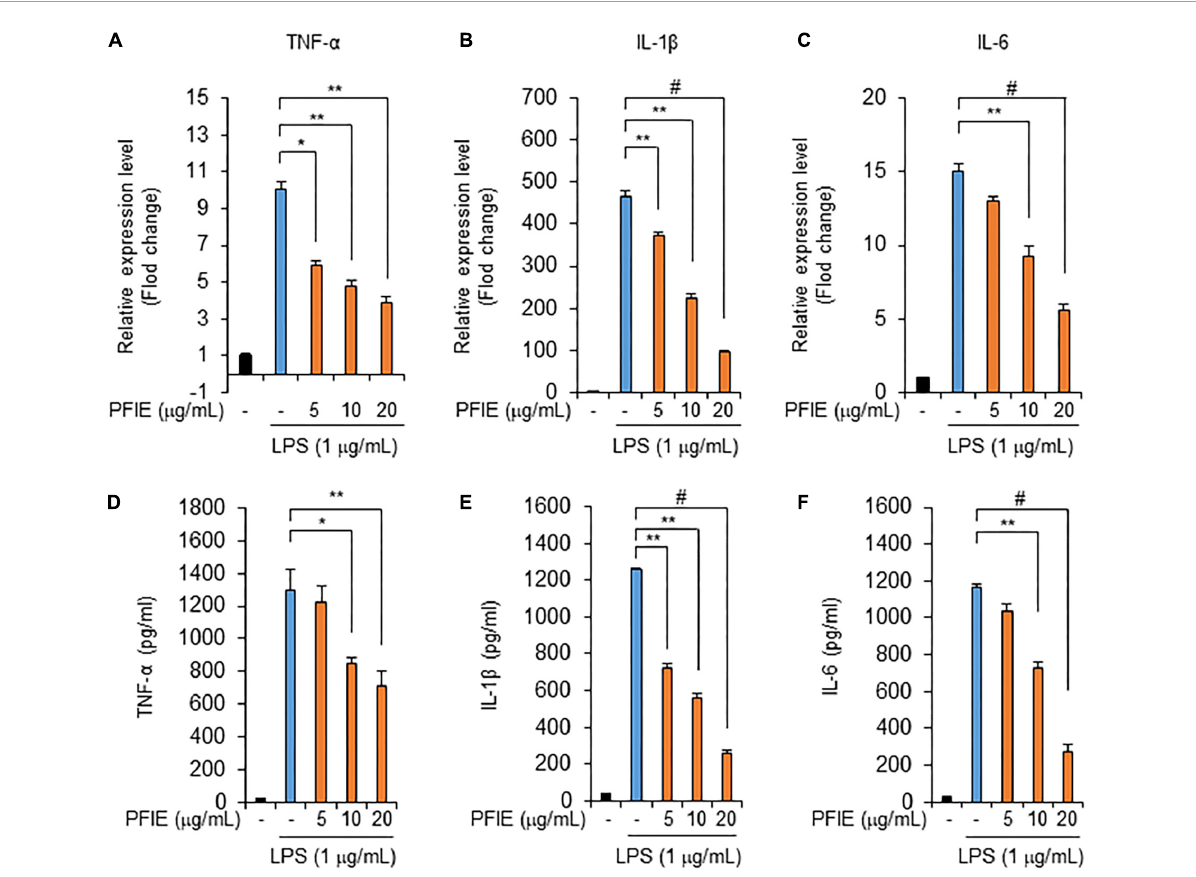
FIGURE2 PFIE suppresses the production of inflammatory cytokines by LPS in J774 cells. Indicated PFIE concentrations were used for pretreatment 1 h prior to treatment with 1 µ g/mL of LPS for 24 h. mRNA levels of panels (A) TNF- α , (B) IL-1 β , and (C) IL-6 were determined using real-time PCR. Relative mRNA expression levels were normalized to those of GAPDH. (D–F) Secreted levels of panel (D) TNF- α , (E) IL-1 β , and (F) IL-6 in the culture medium were measured using ELISA. * P < 0.05, ** P < 0.01, and # P < 0.001 (Student’s t -test). Data are representative of three